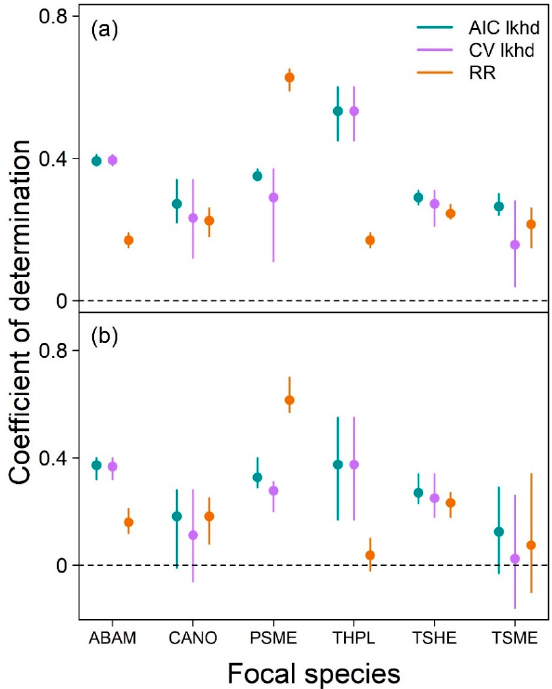
Figure 2. Training fit ( a ) and out-of-sample predictive skill ( b ) of the likelihood and regularized regression models. Likelihood models using AIC and cross-validation for model selection are shown in green and purple, respectively. Regularized regression models are shown in orange. Points and error bars represent the mean and range of coefficients of determination across the four training sets. Raw values are provided in Table S17.